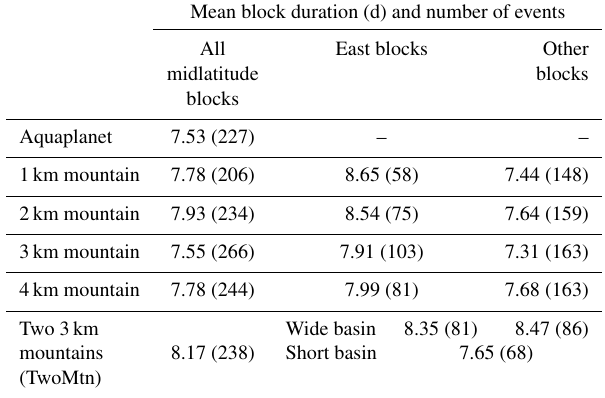
Table 3. Mean block duration and number of events in parentheses for midlatitude, cool-season blocks in each idealized model config- uration.